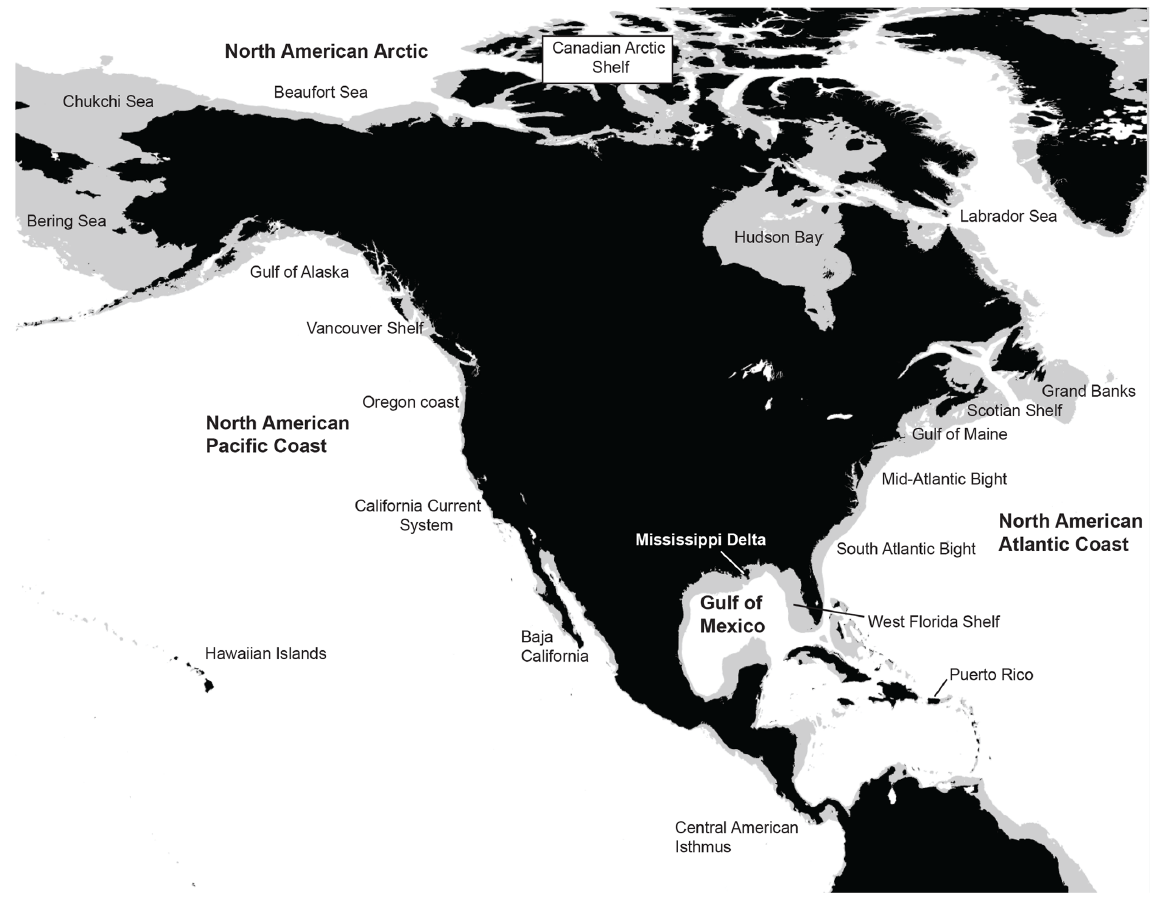
Figure 1. North American continent (in black) with shelf seas (in gray) defined as waters with bottom depths less than 200m. The easternmost tip of Asia and northern part of South America are also shown in